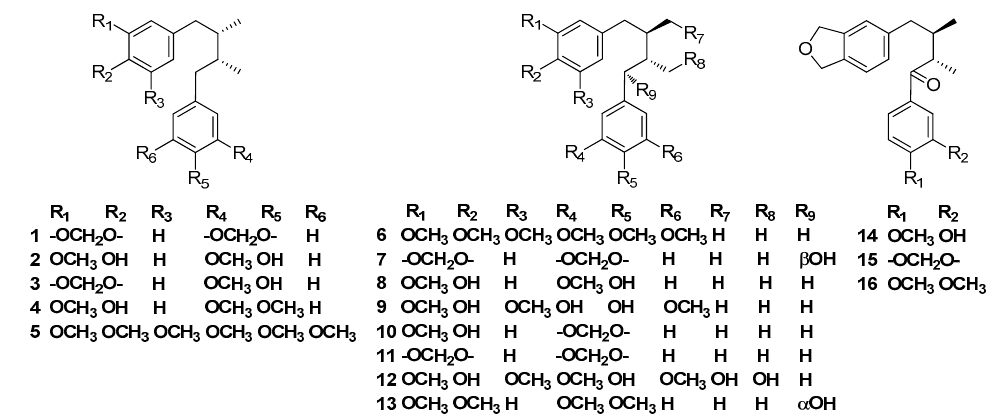
Figure 2. Chemical structures of simple lignans.